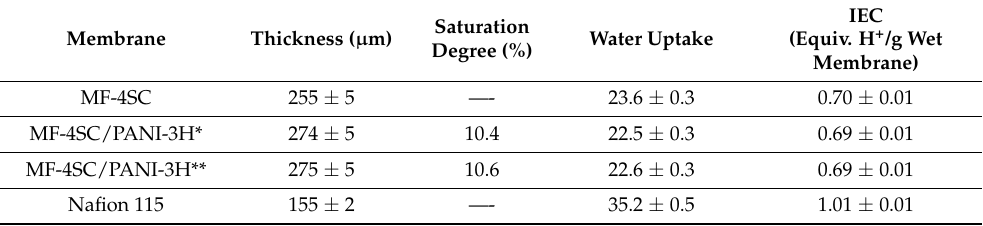
Table 1. Thickness, saturation degree expressed as content of polyaniline (%), water uptake, ion- exchange capacity (IEC) of Nafion and perfluorinated sulfocationic MF-4SC, MF-4SC/PANI-3H*, and MF-4SC/PANI-3H** nanocomposite membranes.